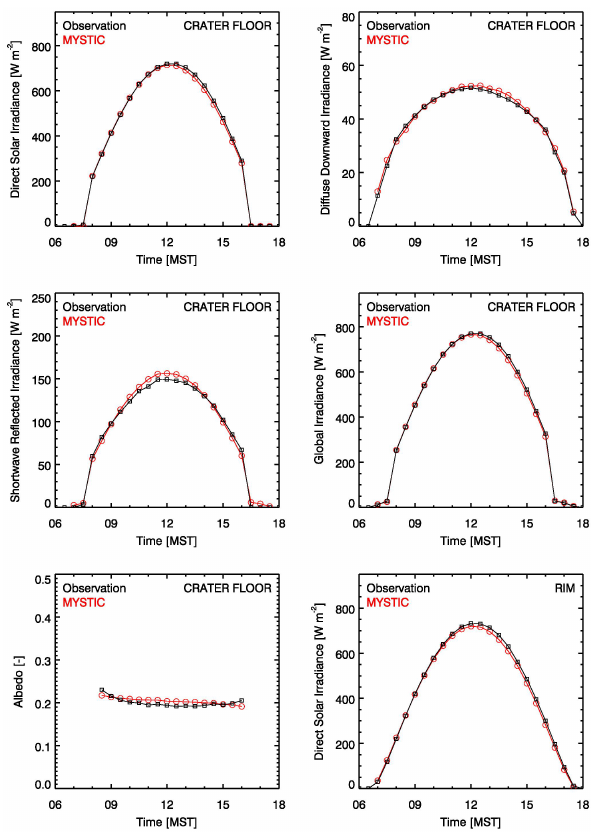
Fig. 6. Observed (black) and modeled (red) slope-parallel global radiation at the six sites in the crater for 21 October